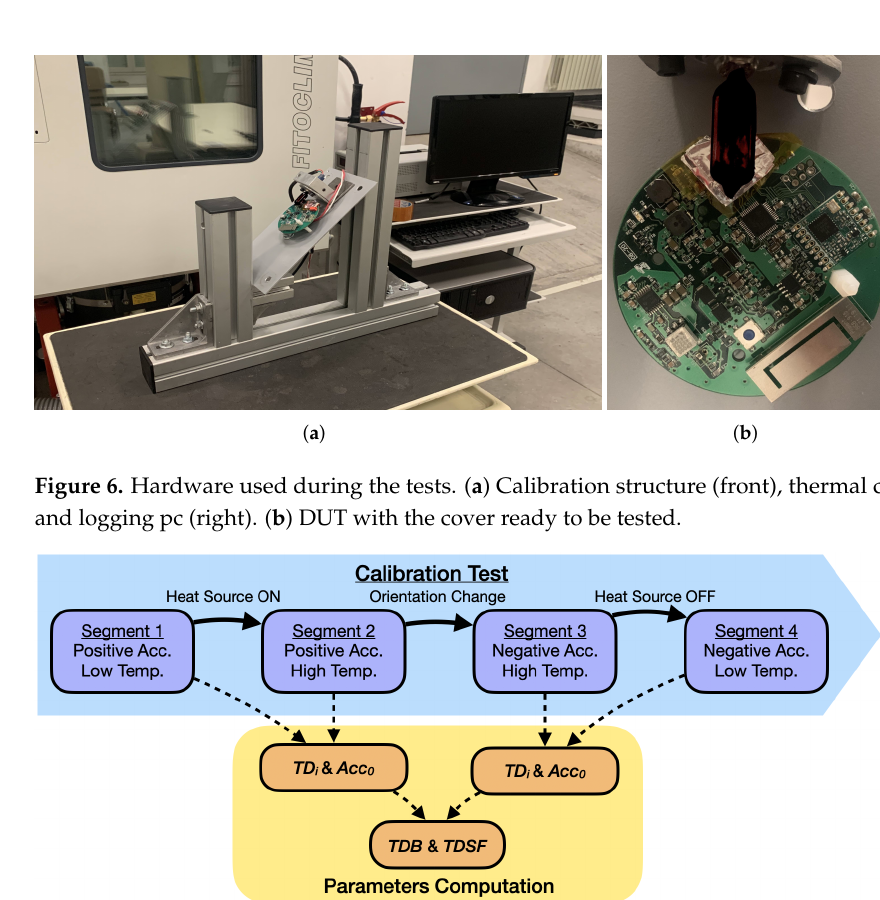
Figure 7. Working flow of the calibration